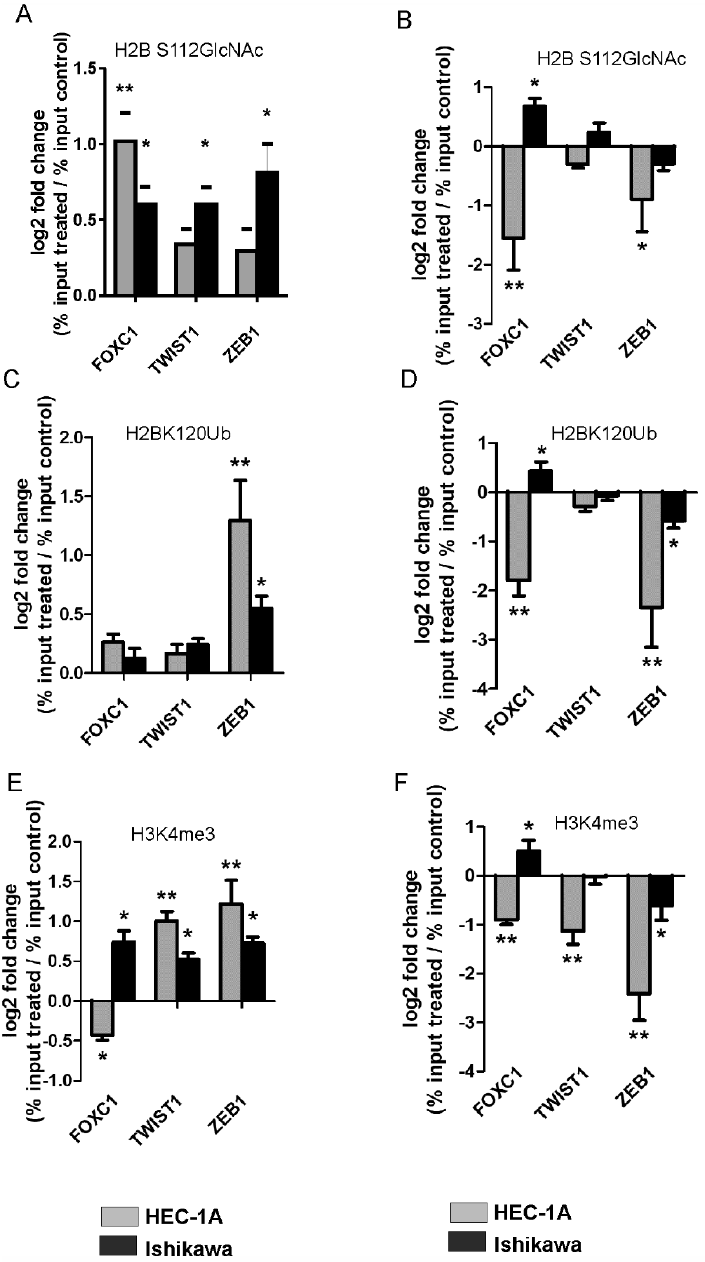
Figure 4. OGT and TET3 dysregulation affect histone modifications. The O-GlcNAcylation of serine 112 of histone H2B (H2BS112GlcNAc), ubiquitination of lysine 120 of histone H2B (H2BK120Ub), and trimethylation of lysine 4 of histone H3 (H3K4me3) have been analyzed using the ChiP method in cells with OGT ( A , C , E ) or TET3 ( B , D , F ) overexpression. Differential chromatin enrichment was quantified using Real-time quantitative PCR. The results were calculated as % input (% input = % input of specific antibodies probes—% input mock IgG) and are presented as a log2fold change (Fold change = % input of treated cells sample/% input of control cells sample). Data show mean ± SE, ( n = 5) * p < 0.01, ** p <